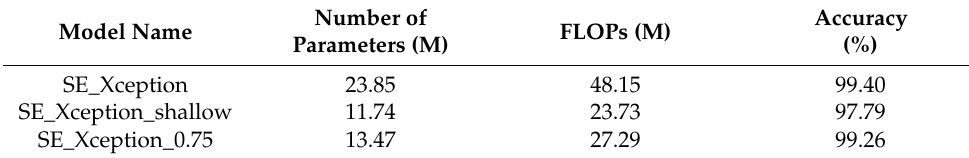
Table 2. Comparison of shallower and narrower